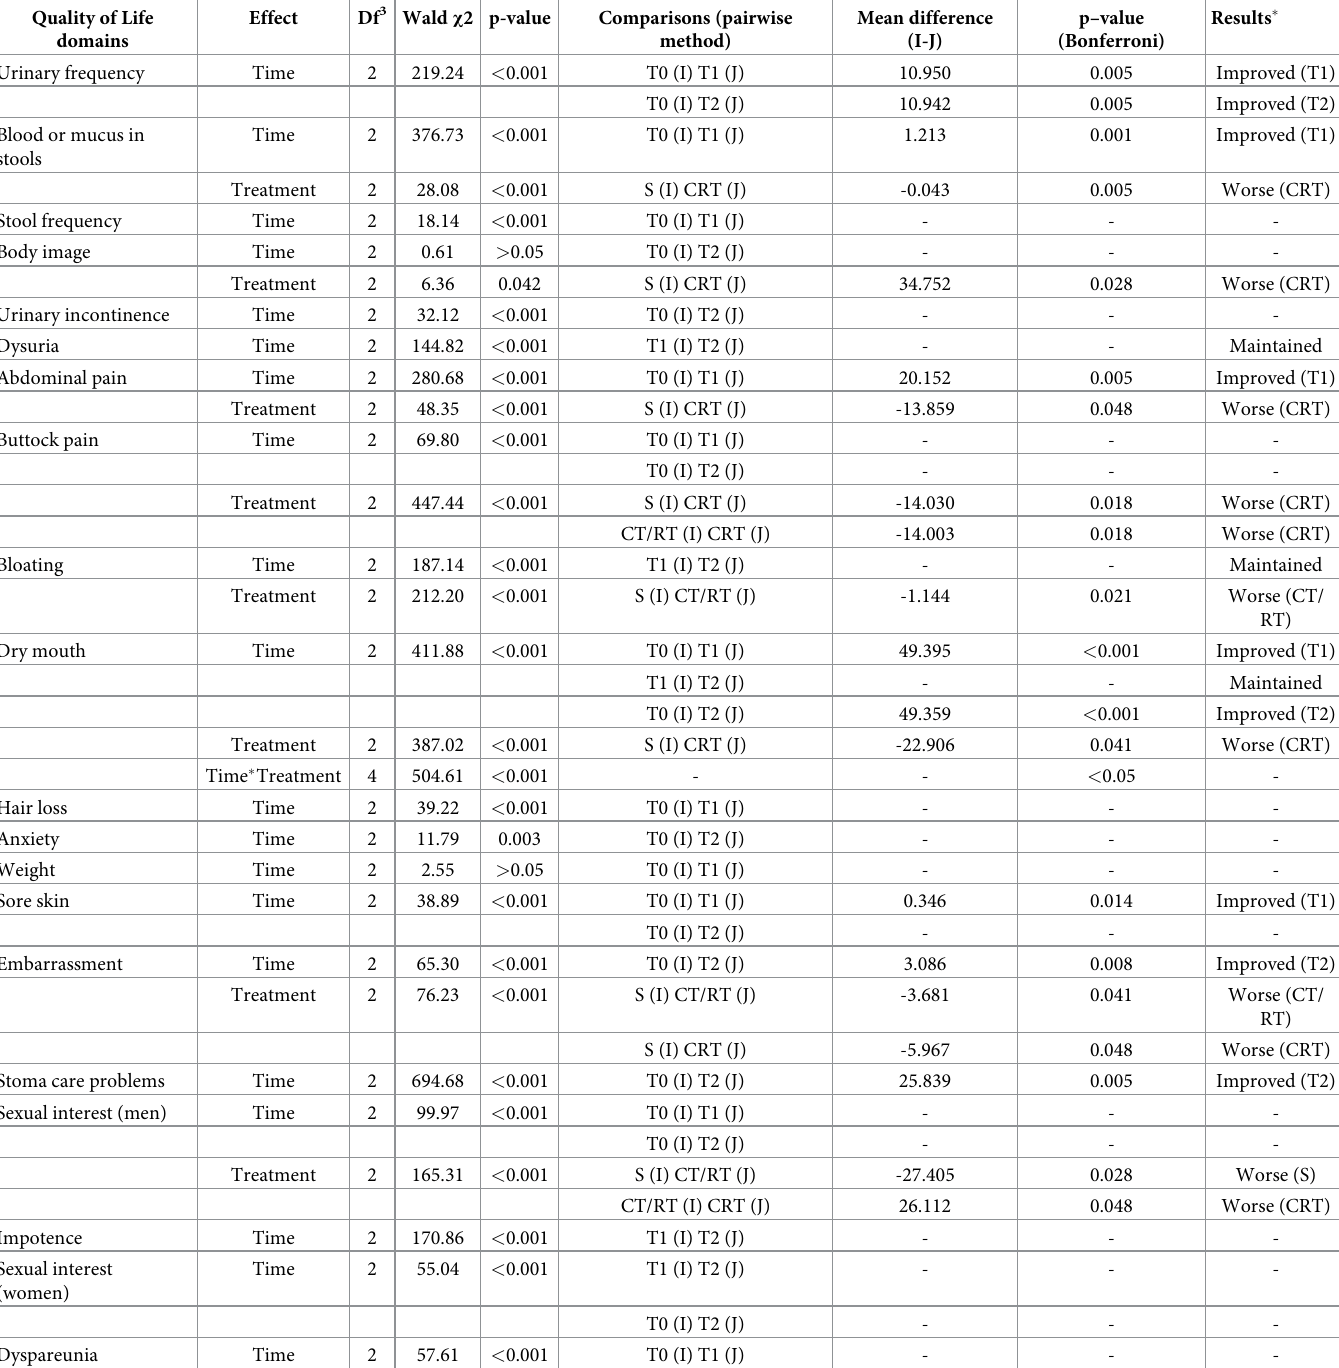
Table 5. Model effect, comparisons and post hoc test of the variables of quality of life of EORTC QLQ-CR29 with time and treatment factors using Generalized Esti- mating